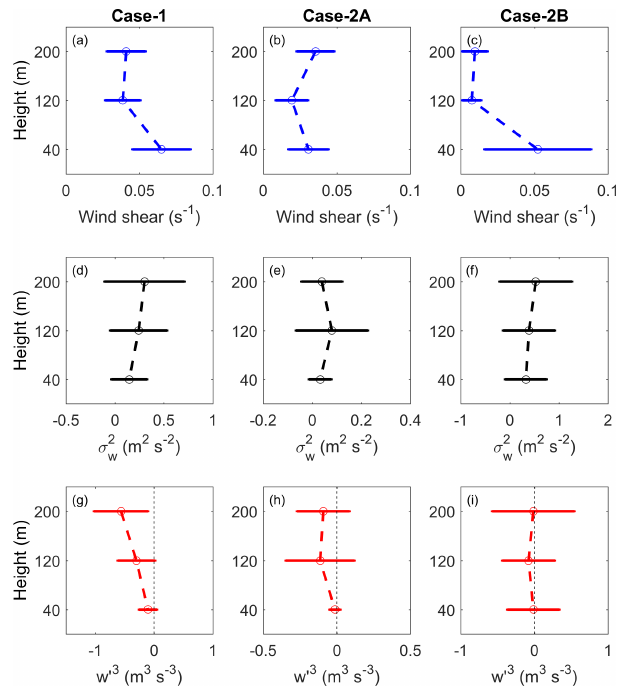
Figure 10. Vertical structure of (a)–(c) wind shear, (d)–(f) variance of vertical wind speed σ 2 w , and (g)–(i) vertical transport of vertical velocity variance w (cid:48) 3 during 00:00–06:00 on 27 December 2016 (left), 00:00–06:00 on 26 January 2017 (center), and 00:00–06:00 on 29 January 2017 (right). The circles of the error bar denote the mean value, and the width of the bar represents the standard devia-